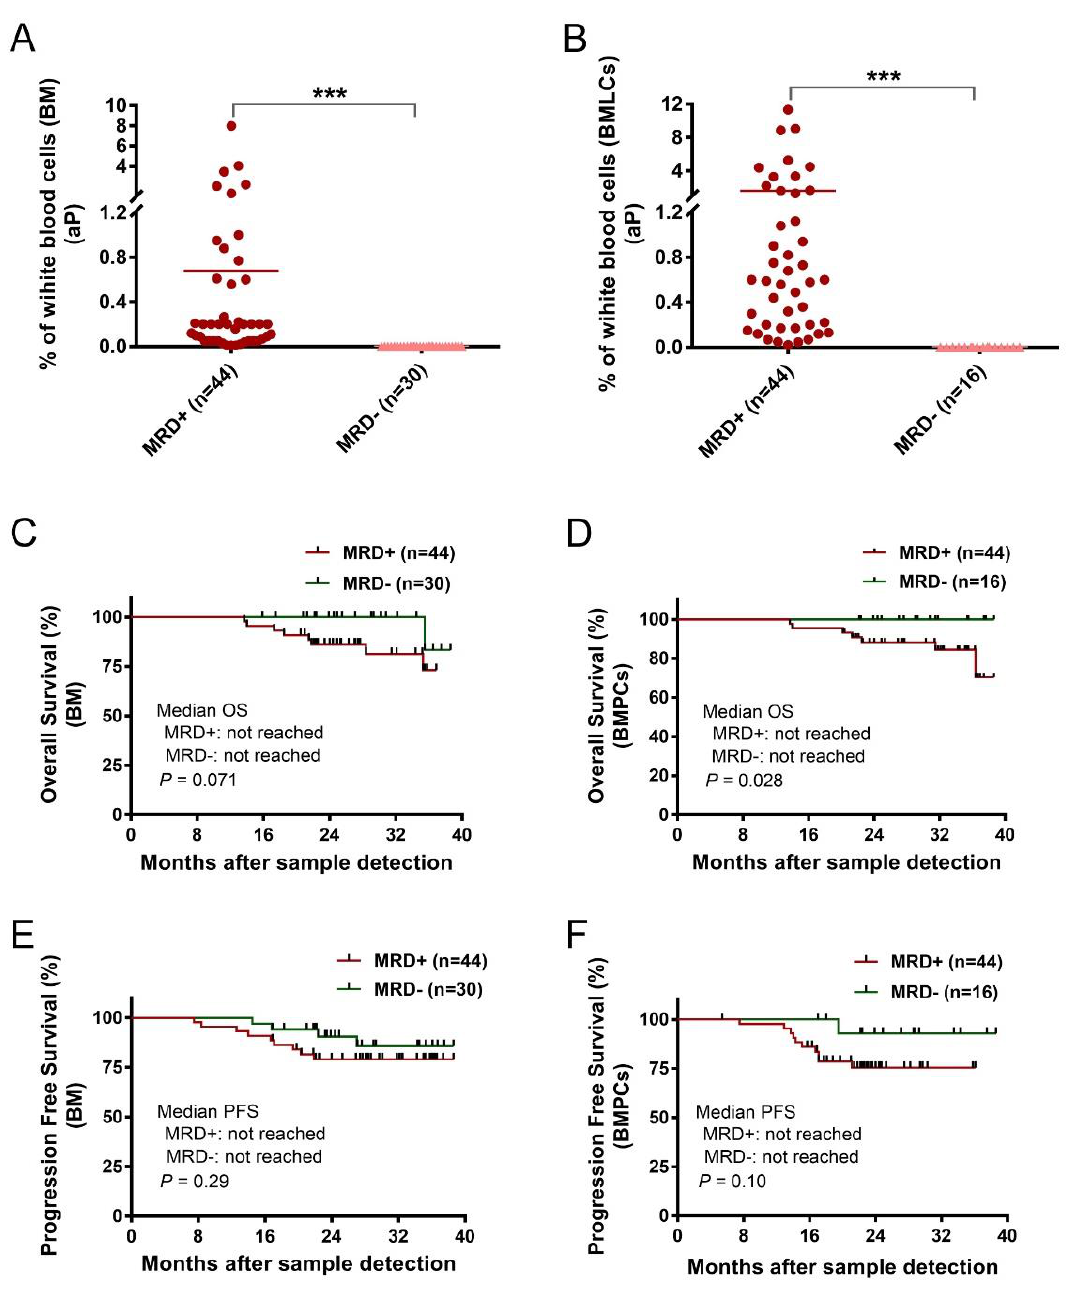
Figure 2. ( A , B ) Two groups of patients’ samples after treatment, MRD + ( ≥ 10 − 4 ) and MRD − (<10 − 4 ), were assessed with conventional bone marrow (BM) samples or enriched bone marrow particle cell (BMPL) samples. The percentages of aberrant plasma cells (aPCs) in the MRD + samples (BM: n = 44; BMPL: n = 44) were significantly higher (BM: *** p < 0.001; BMPL: *** p < 0.001) than those in the MRD − samples (BM: n = 30; BMPL: n = 16). ( C , D ) BM ( n = 60) or BMPL ( n = 74) samples from patients after therapy were divided into MRD + ( ≥ 0.001% aPC) and MRD − (<0.001% aPC). Kaplan–Meier was used to estimate the overall survival (OS); no differences were observed between the MRD − group and the MRD + group in the BM samples ( p = 0.071) ( C ); however, the MRD − patients had a longer OS than the MRD + cohort in the BMPL samples ( p = 0.028). ( D – F ) Progression-free survival (PFS) was determined for the MRD − and MRD + cohort in the BM samples ( p = 0.297) and in the BMPL samples ( p = 0.101). The graphs show the mean ( A , B ), Mann–Whitney U test ( A , B ), and the Kaplan–Meier method ( C – F